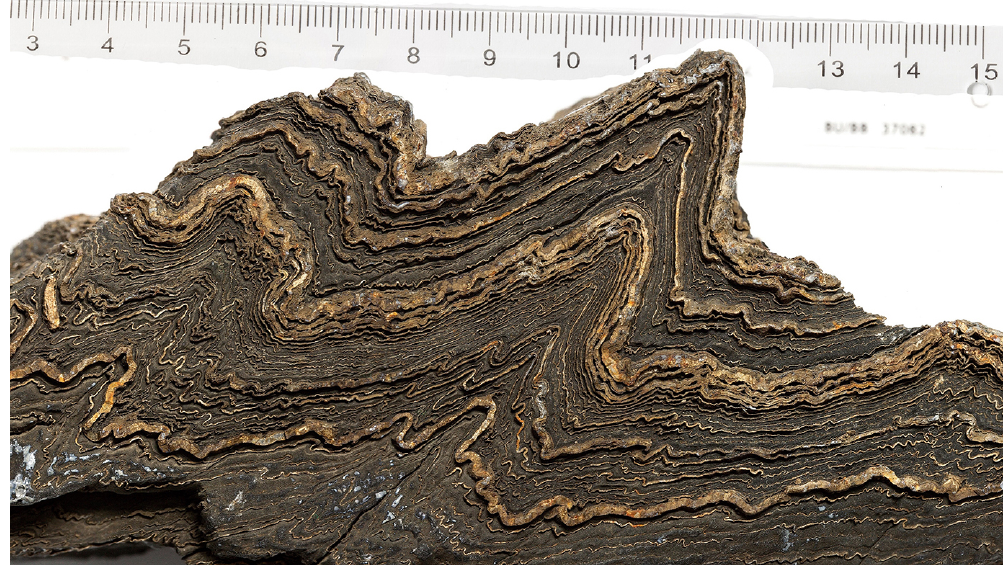
Figure 10. Multilayer folds showing that the size of individual folds (quantified by distance between neighbouring hinges of the same type) is related to their layer thickness and that folds become systematically smaller as their layer thickness becomes thinner. Carbonates with silicate-rich layers belonging to the Jurassic El Quemado formation. The sample was found by Stéphane Leresche around the Mount Fitz Roy, southern Patagonia, and the photo was made by Yoann Jaquet.